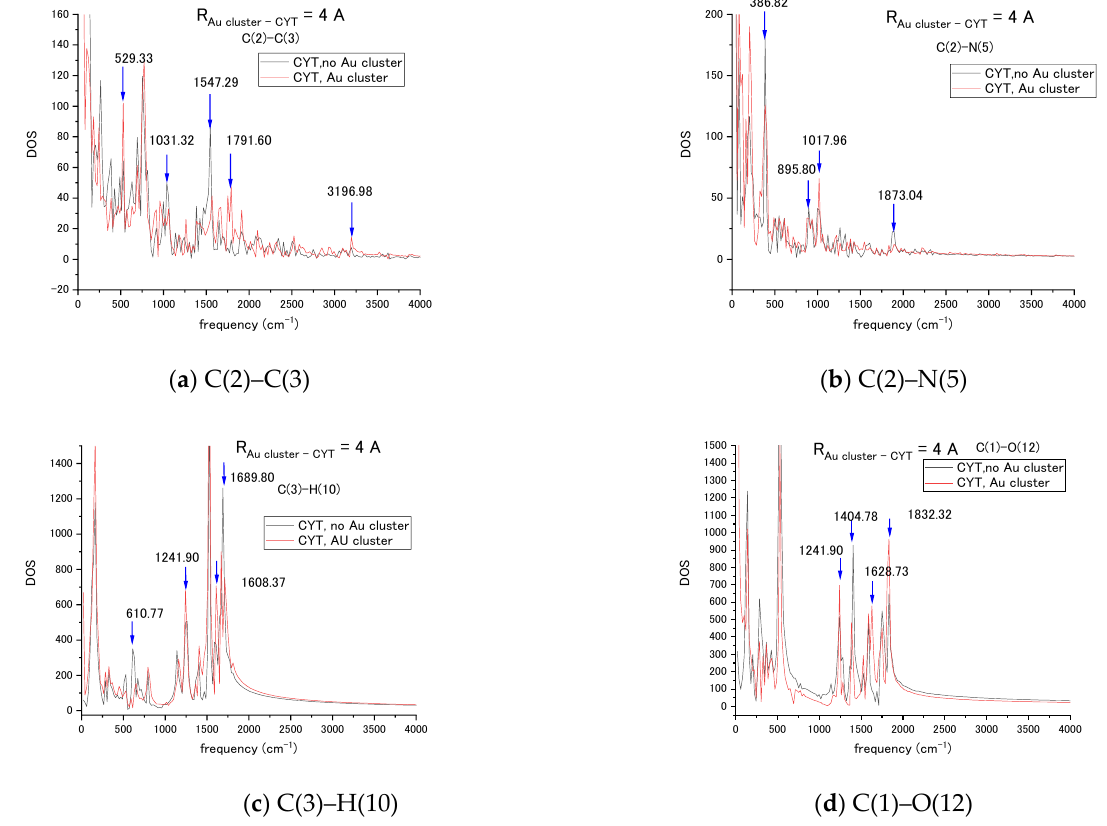
Figure 7. Vibrational spectra of the cytosine (CYT) bonds ( a ) C(2)–C(3), ( b ) C(2)–N(5), ( c ) C(3)–H(10), and ( d ) C(1)–O(12) in the absence and presence of interaction with the Au 20 NP. Changes in spectra such as mode shifts and large amplitude changes are marked by vertical